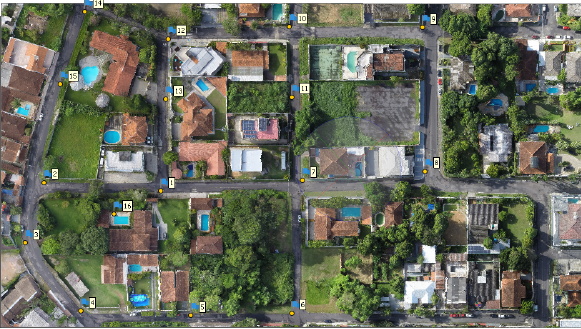
Figure 13. Distances between CAMPOS and nadir dense point